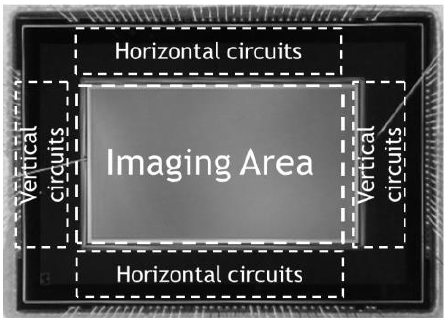
Figure 9. A micrograph of a developed TOF-CIS.